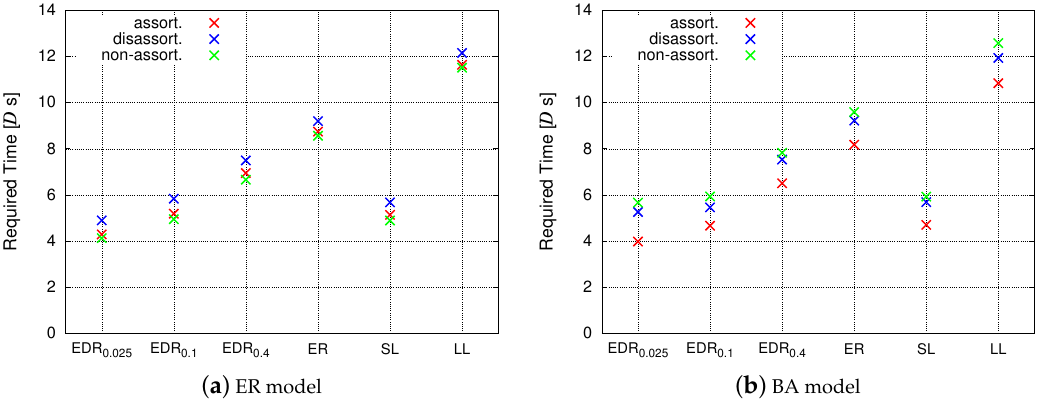
Figure 12. Communication efficiency (propagation delay).